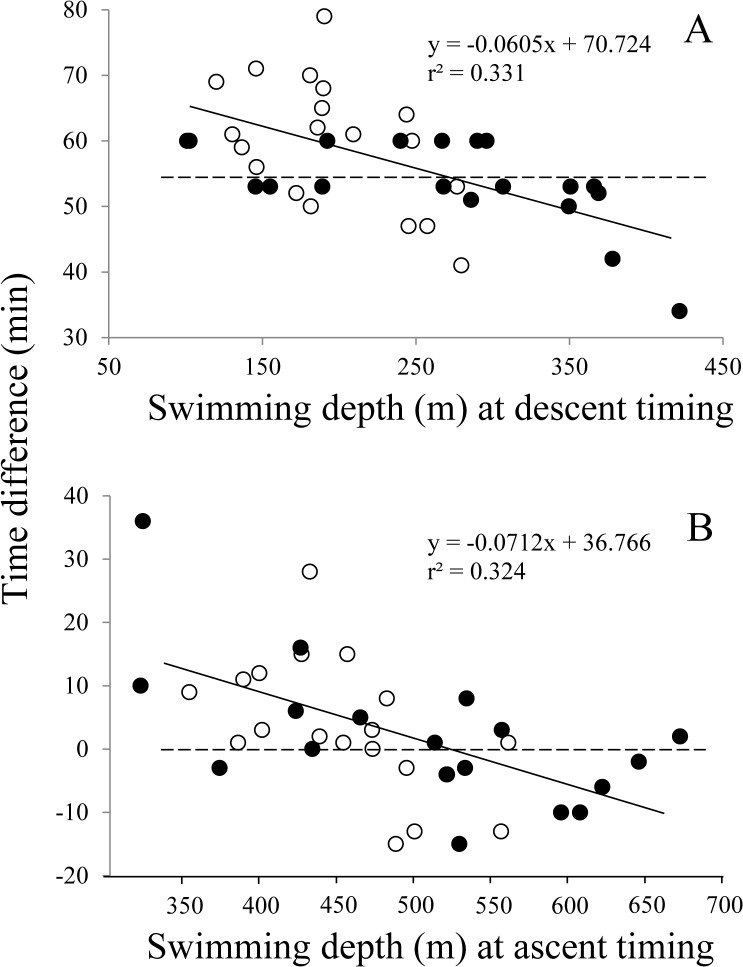
Time difference between descent timing and sunrise (A) and between ascent timing and sunset (B) plotted against migration depth at descent or ascent timing.Regression line is shown by a solid line. Dotted lines indicate 55 min difference in dawn and 0 min in dusk. Eels start descent approximately one hour before sunrise, corresponding to nautical dawn, in which individuals swimming at a shallower layer start descent earlier than those swimming at a deeper layer. Ascent in the evening is closely associated with sunset, in which individuals swimming at a shallower layer start ascent later than those swimming at a deeper layer. Observations in TS and KC areas are shown by open and closed circles, respectively.